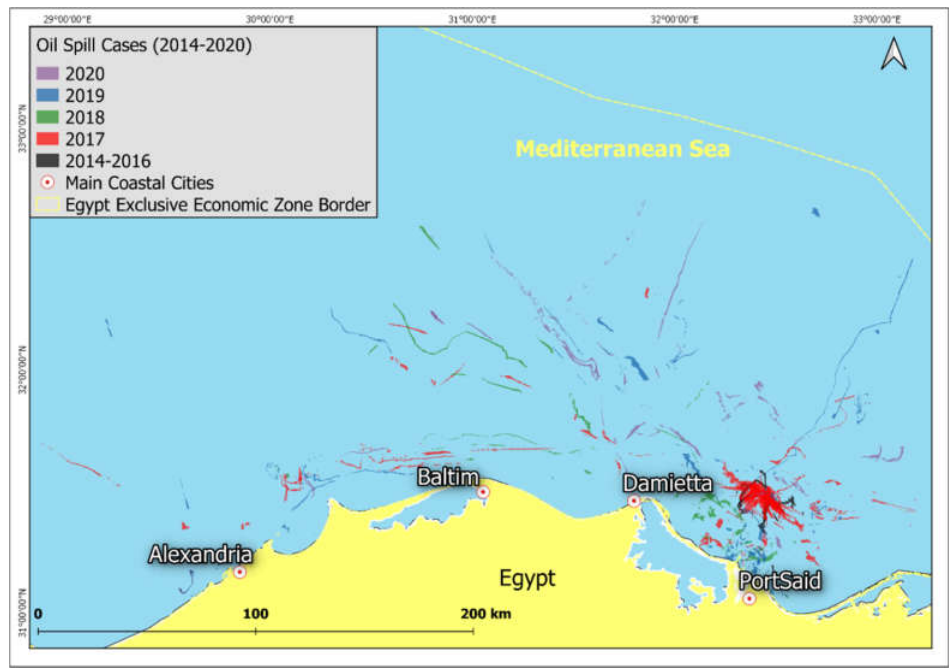
Figure 8. Spatial distribution of the cumulative frequency of 218 oil spill cases detected along the Egypt Mediterranean coast in the period from 2014 to 2020.